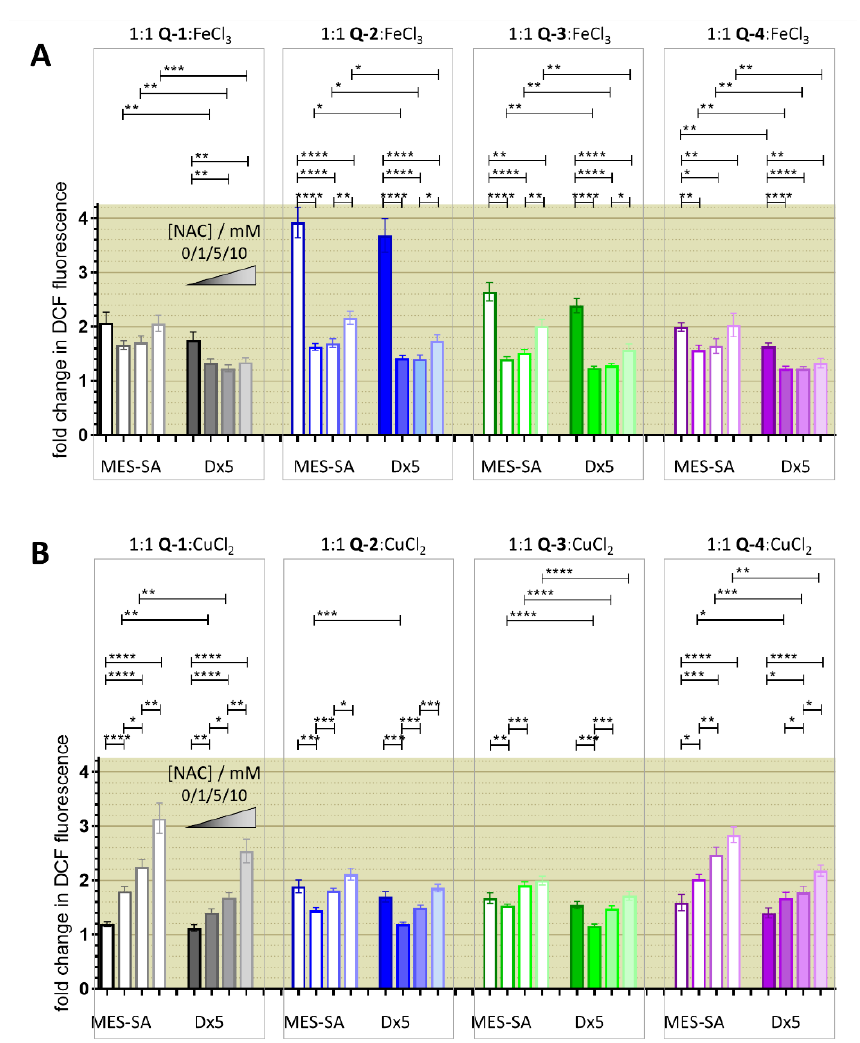
Figure 6. Characterization of intracellular ROS production with the DCFDA assay. Fold changes in fluorescence are shown after a 90 min incubation with 6.25 µM of the ligands Q-1 to Q-4 in the presence of an equimolar amount of iron ( A ) and copper ( B ). Values are given as mean with SEM of three-to-five independent experiments performed in duplicate. NAC increases the DCF fluorescence upon treatment in Pgp negative MES-SA (open columns) and Pgp positive MES-SA/Dx5 (Dx5, filled columns) in a concentration dependent manner (fading color indicates increasing NAC concentration from 0, 1, 5, 10 mM). Significance is given as *: p ≤ 0.05, **: p ≤ 0.01, ***: p ≤ 0.001, ****: p ≤ 0.0001.